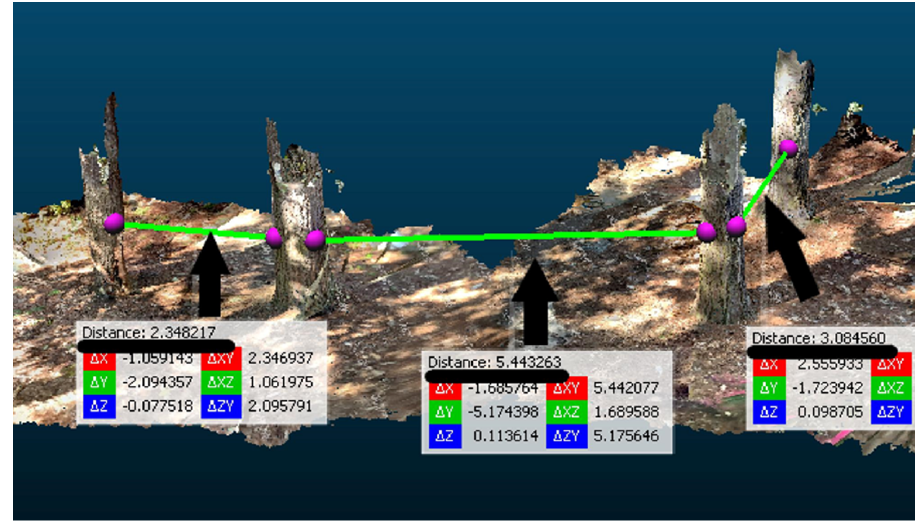
Figure 9. Measuring distance between trees in CloudCompare software.